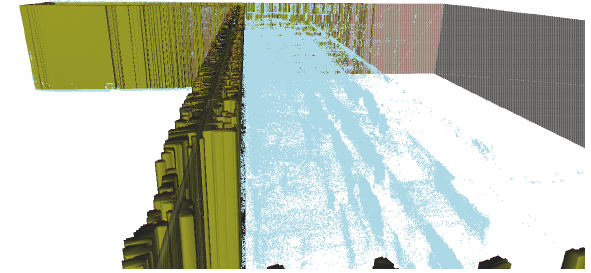
Figure 10. P moderate as an indicator of possible deviations between raw model (gray) and MLS observations (blue). Such deviations indicate possibility of unmodeled surfaces.